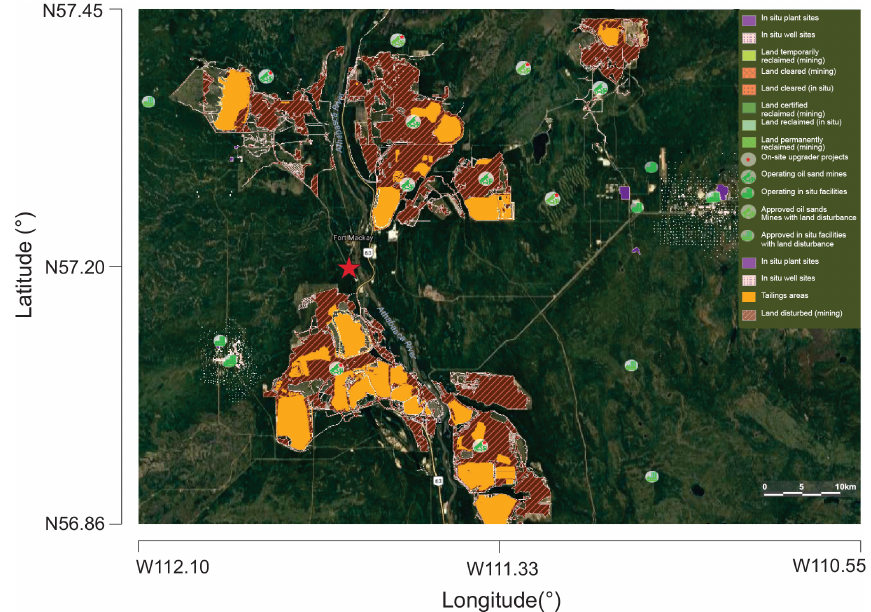
Figure 1. Map of oil sands facilities showing locations of surface mines and tailing ponds, downloaded from the Oil Sands Information Portal (Alberta, 2017). The red star indicates the location of AMS